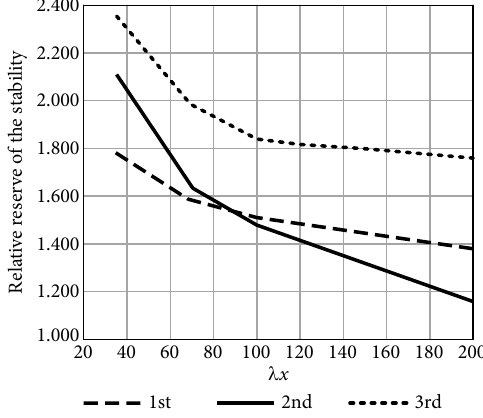
Fig. 7. General buckling correction factors (cid:68)